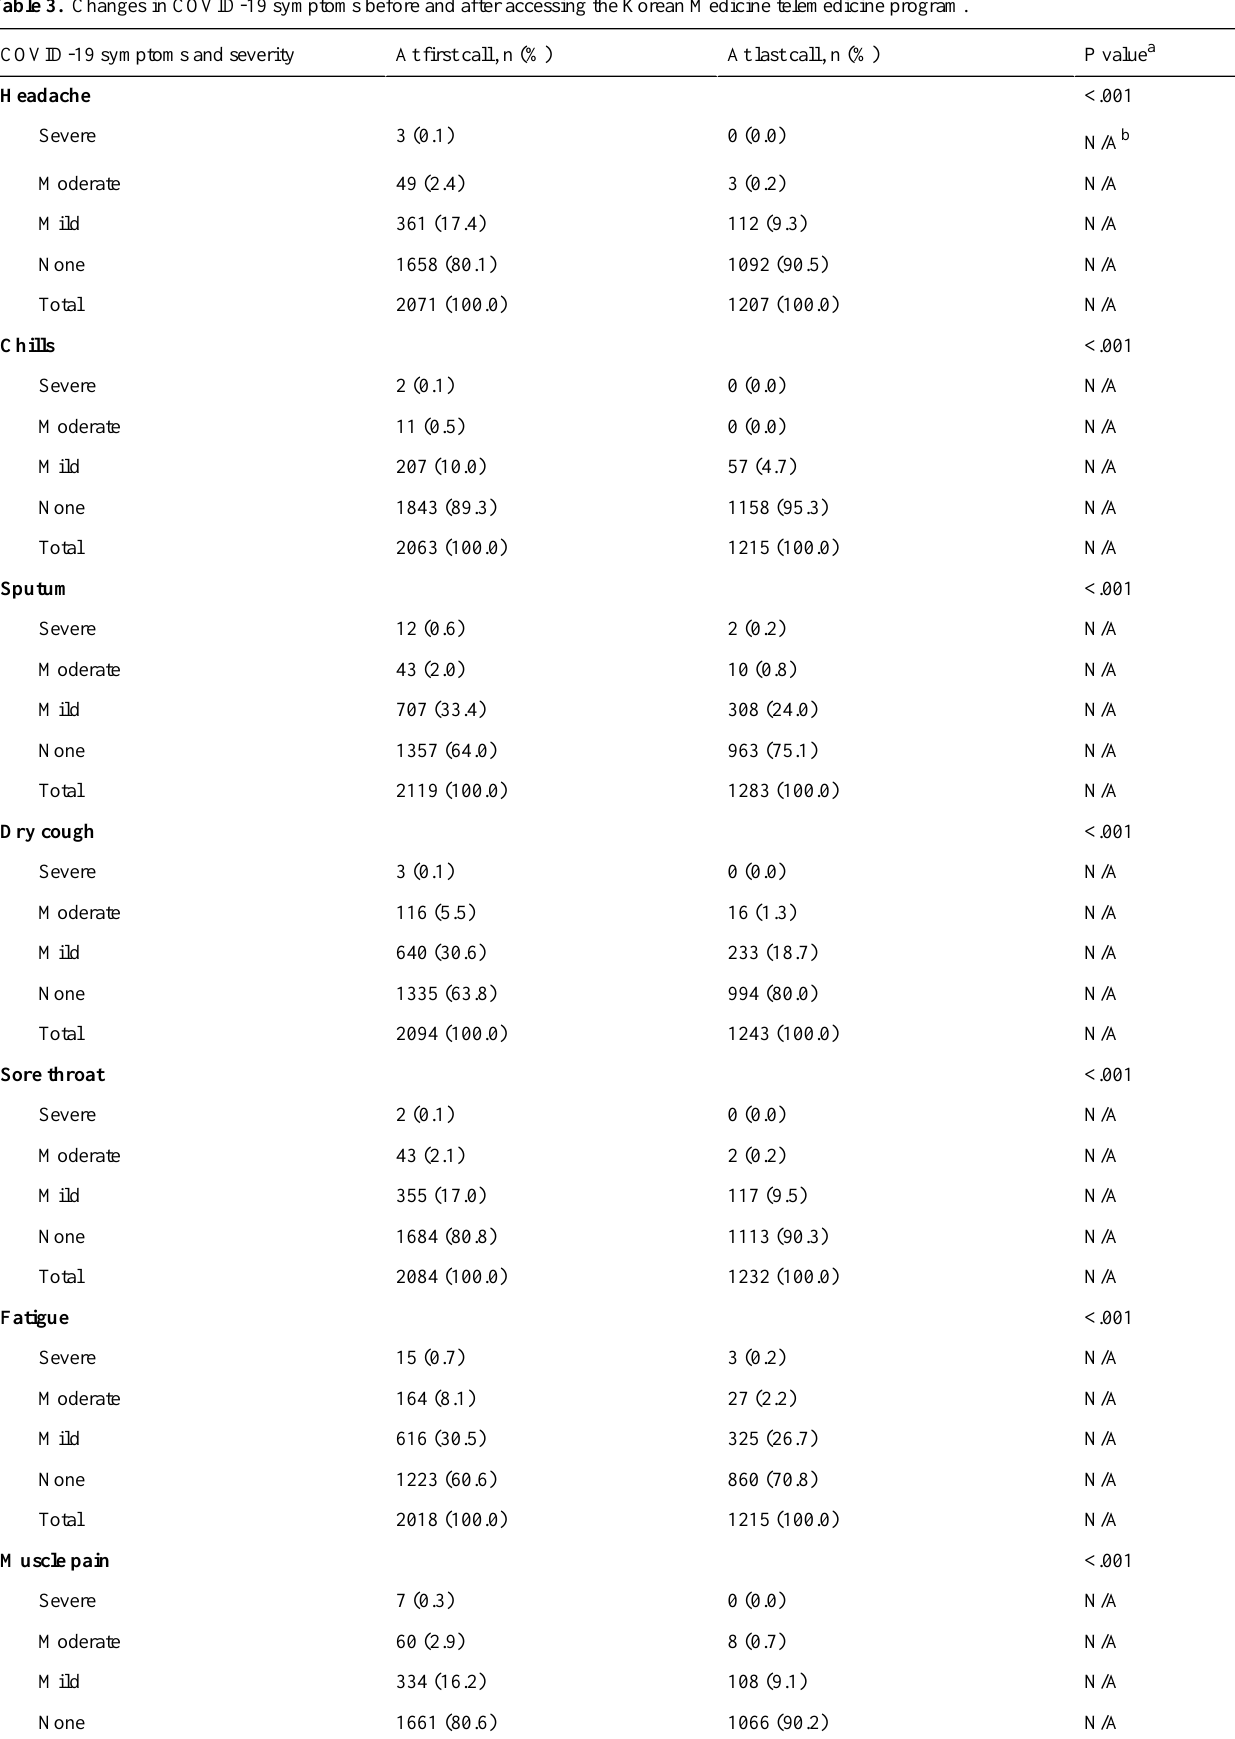
Table 3. Changes in COVID-19 symptoms before and after accessing the Korean Medicine telemedicine program.